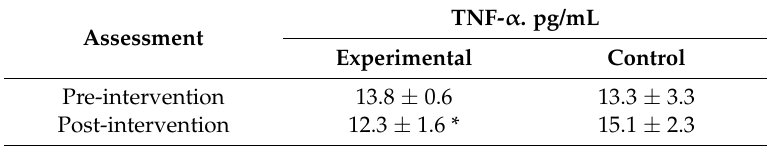
Table 3. Comparison of TNF- α levels in the experimental and the control groups pre- and post-intervention.